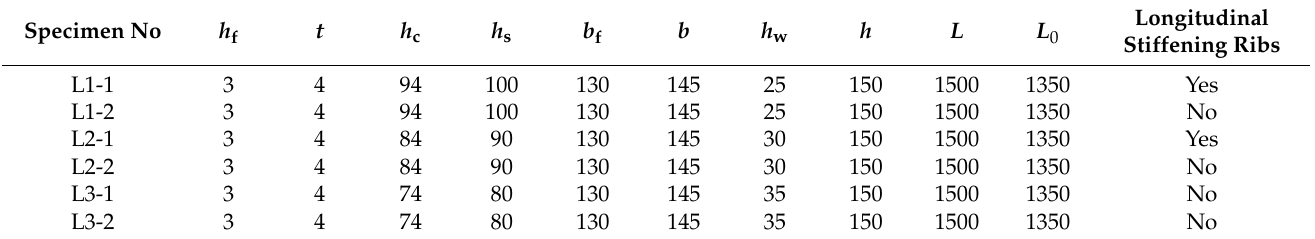
Table 1. Main design parameters of the specimen (unit: mm).